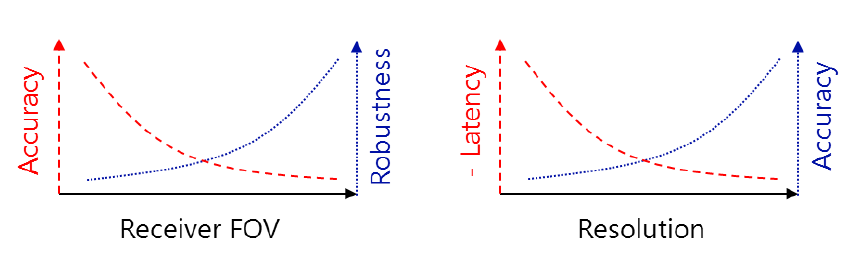
Figure 15. Trade-offs in VLC based positioning. ( Left ) Trade-off regarding to receiver FOV; ( Right ) Trade-off regarding to image sensor